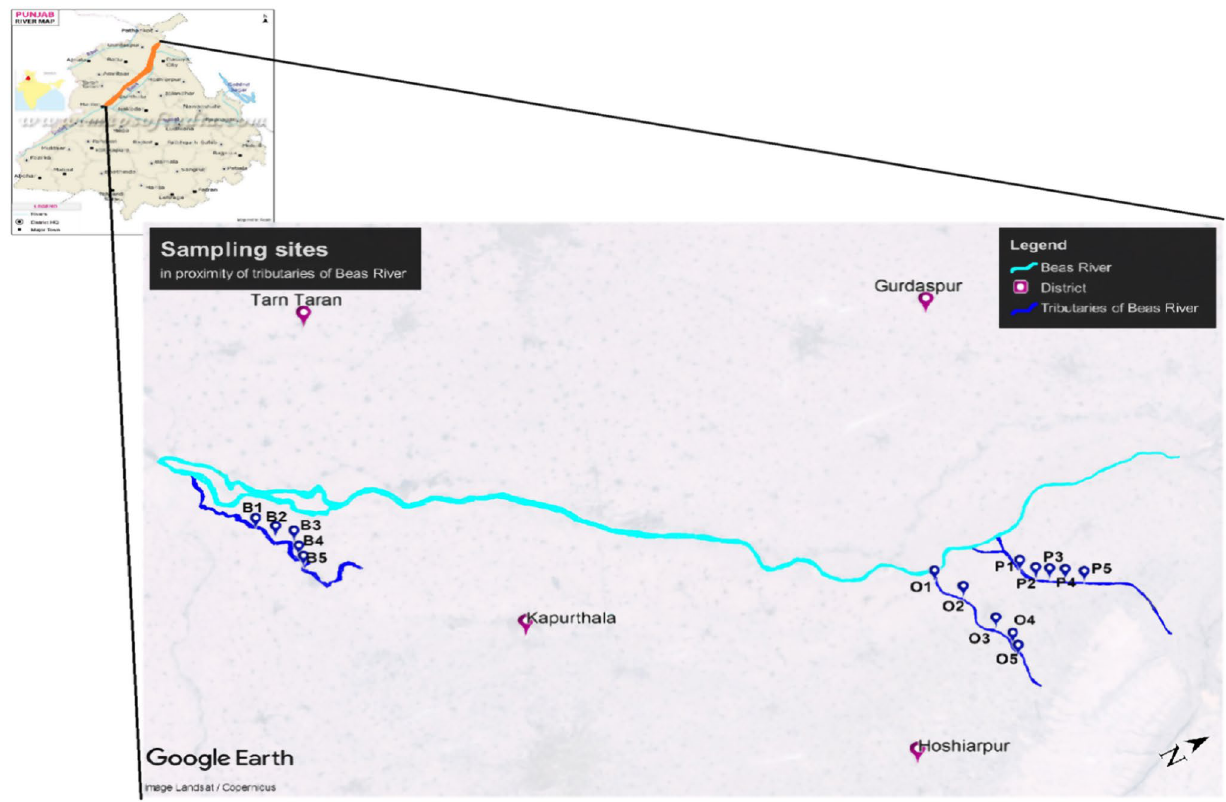
Fig. 1 Location map of sampling sites in the proximity of tributaries of Beas River,